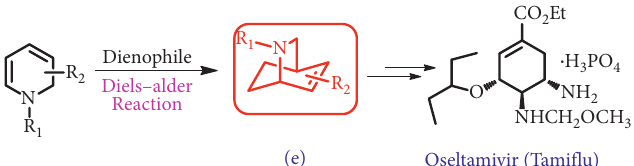
Figure 2: Structures of some medicinally important compounds/cores accessible from